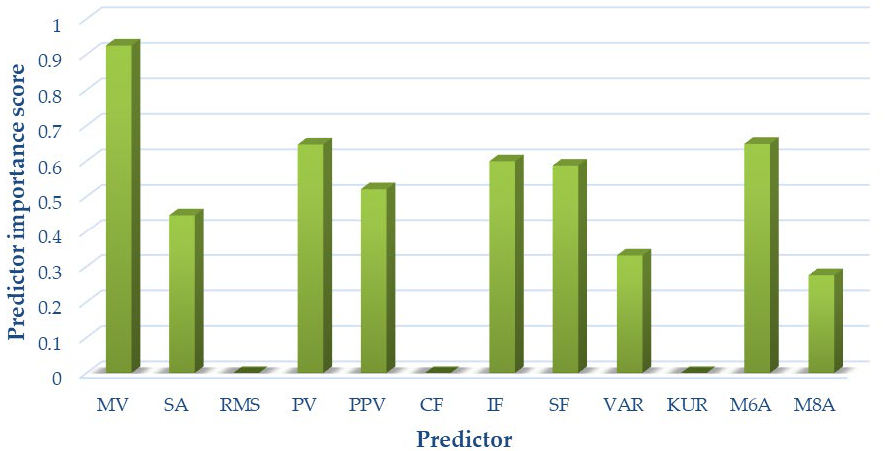
Figure 9. Selection of optimal features for variant II (CKC).